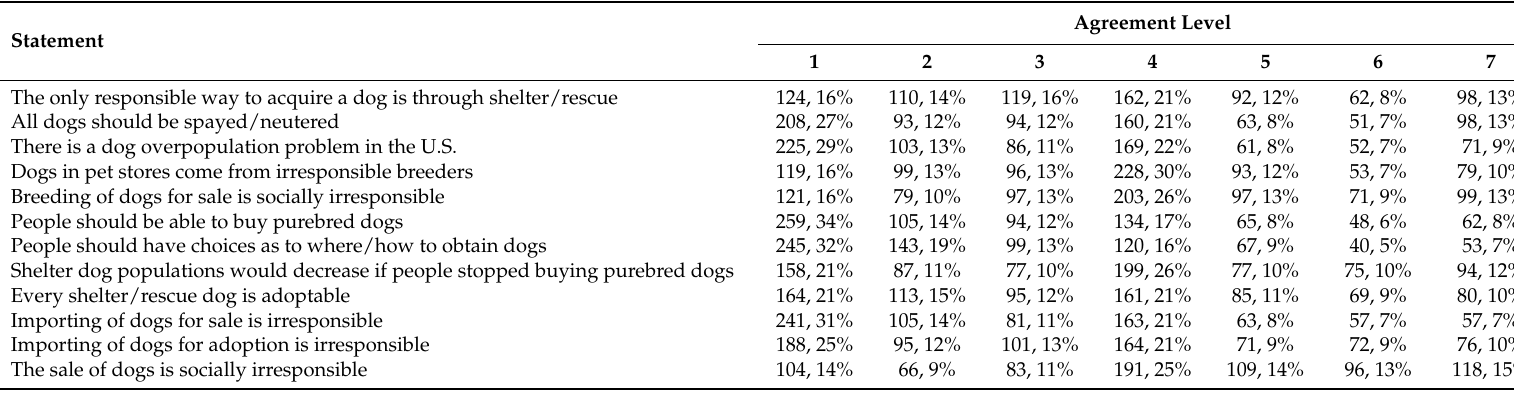
Table 3. Respondents’ beliefs regarding dog acquisition from a scale of 1 (agree) to 7 (disagree). Number of respondents, then percentage of respondents (number, percentage) (n =